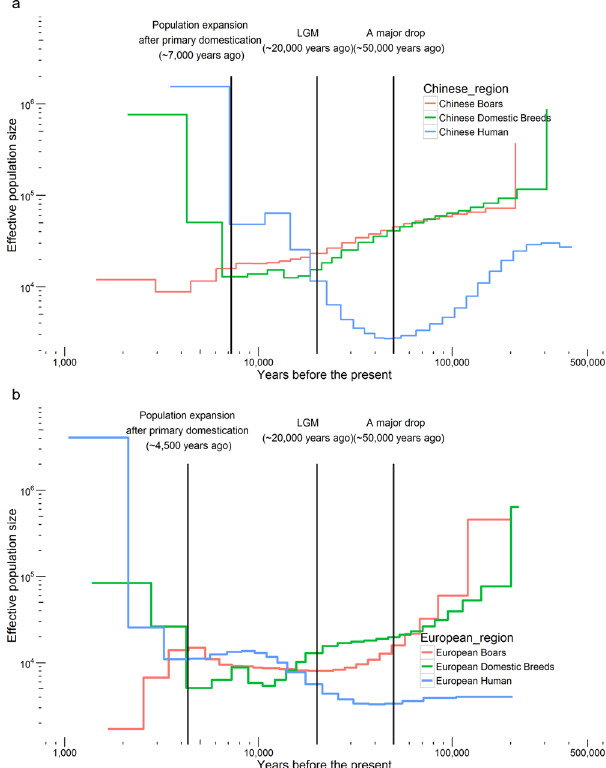
Figure 2. Demographic history of domestic breeds and wild boars in China and Europe. The demographic history of wild boars and domesticate pigs populations was inferred using a hidden Markov model approach as implemented in multiple sequentially Markovian coalescence based on SNP distribution. In the absence of known mutation rates for pig, we used the default mutation rate for human of 2.5 × 10 − 8 . For the generation time we used an estimate of 5 years. The data for human’s effective population size refer to previous research 51 . ( a ) Demographic history of domestic breeds and wild boars in Chinese region. 2 individuals were used to indicate the group (2 Rongchang pigs, CHD; 2 North China wild boars, CHW). ( b ) Demographic history of domestic breeds and wild boars in European region. 2 individuals were used to indicate the group (2 Pietrain pigs, EUD; 2 Netherlands wild boars,